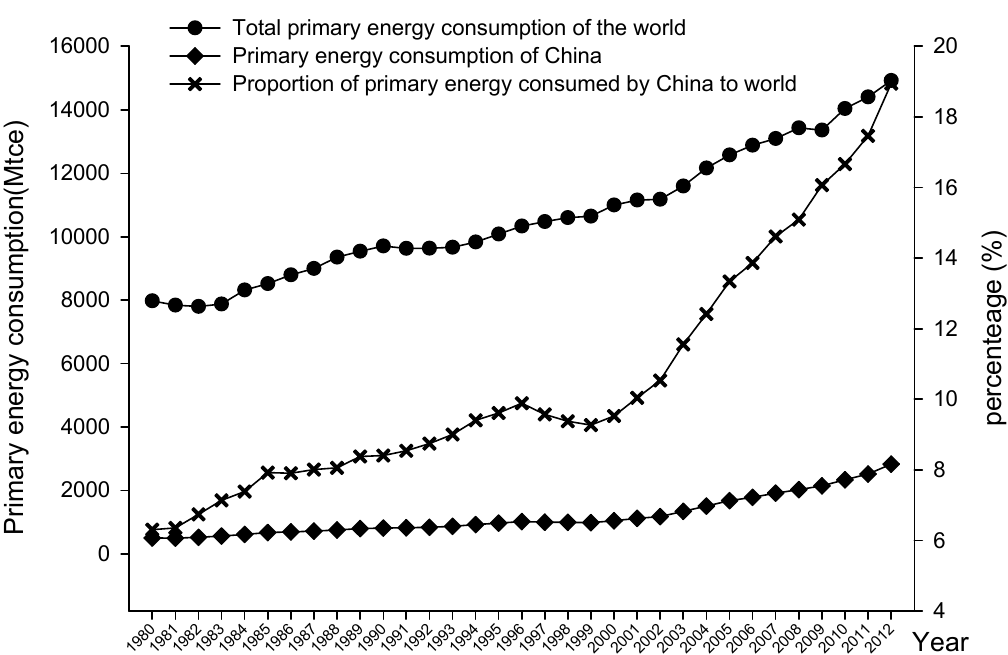
Figure 1. The total primary energy consumption during 1980 to